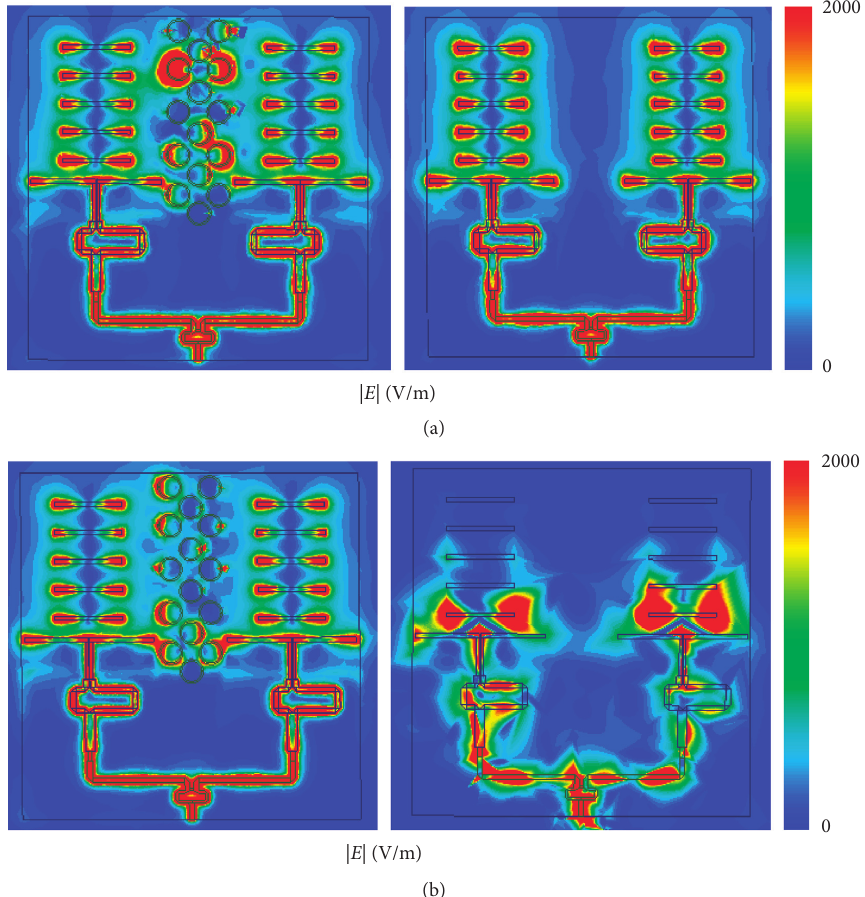
Figure 12: Electric field intensity distribution of the antenna array (0.2 λ